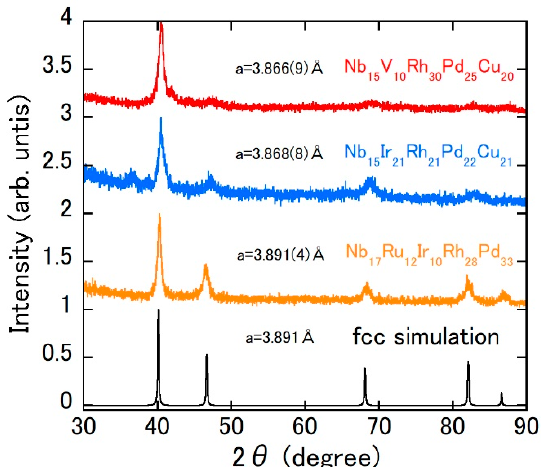
Figure 10. XRD patterns (Cu-K α ) of Nb 15 V 10 Rh 30 Pd 25 Cu 20 , Nb 15 Ir 21 Rh 21 Pd 22 Cu 21 and Nb 17 Ru 12 Ir 10 Rh 28 Pd 33 . The simulation pattern of the face-centered-cubic (fcc) phase with a = 3.891 Å is also shown. Each pattern is shifted by an integer value for clarity. The lattice parameters were determined with the help of the Rietveld refinement program [38,39].